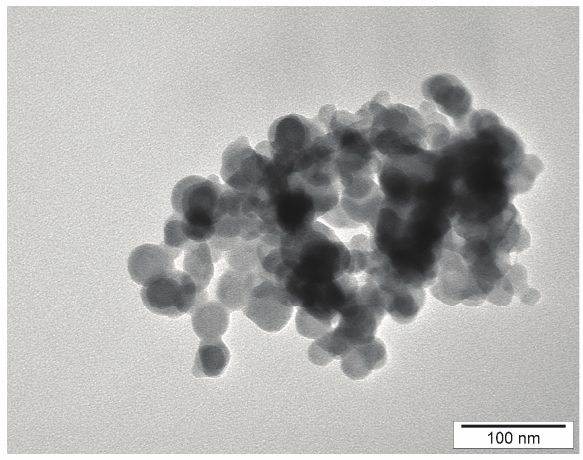
Figure 2. Transmission electron microscopic image of Cu